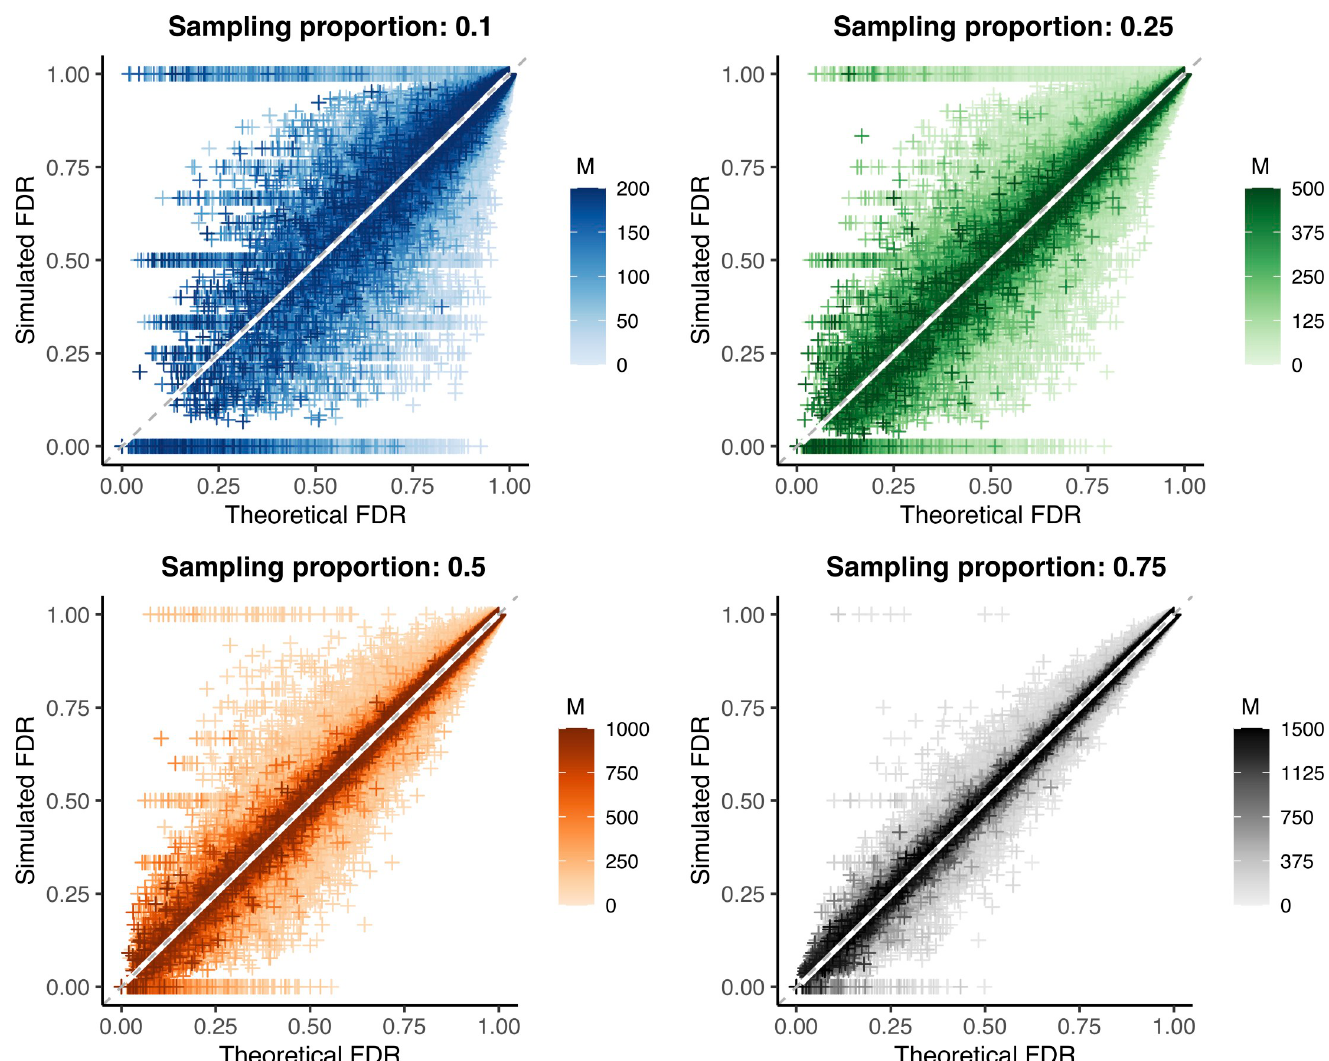
Fig 3. Predicted versus observed false discovery rate in outbreak simulations. Theoretical versus simulated false discovery rate (FDR) for each genetic distance threshold in 10,000 simulations of varying substitution rate and reproductive number (approximately 260,000 points per plot, see Tables 2 and 3 ). Outbreak sizes range from 100–2000, as described in Methods . White line: smoothed conditional mean; grey dashed line: y = x line. Increasing values of the sample size ( M ) are plotted in darker color; because the maximum outbreak size is fixed at 2000, the maximum sample size differs for each sampling proportion. Increasing both the sample size and proportion reduces bias and error, see Tables 2 and 3 .